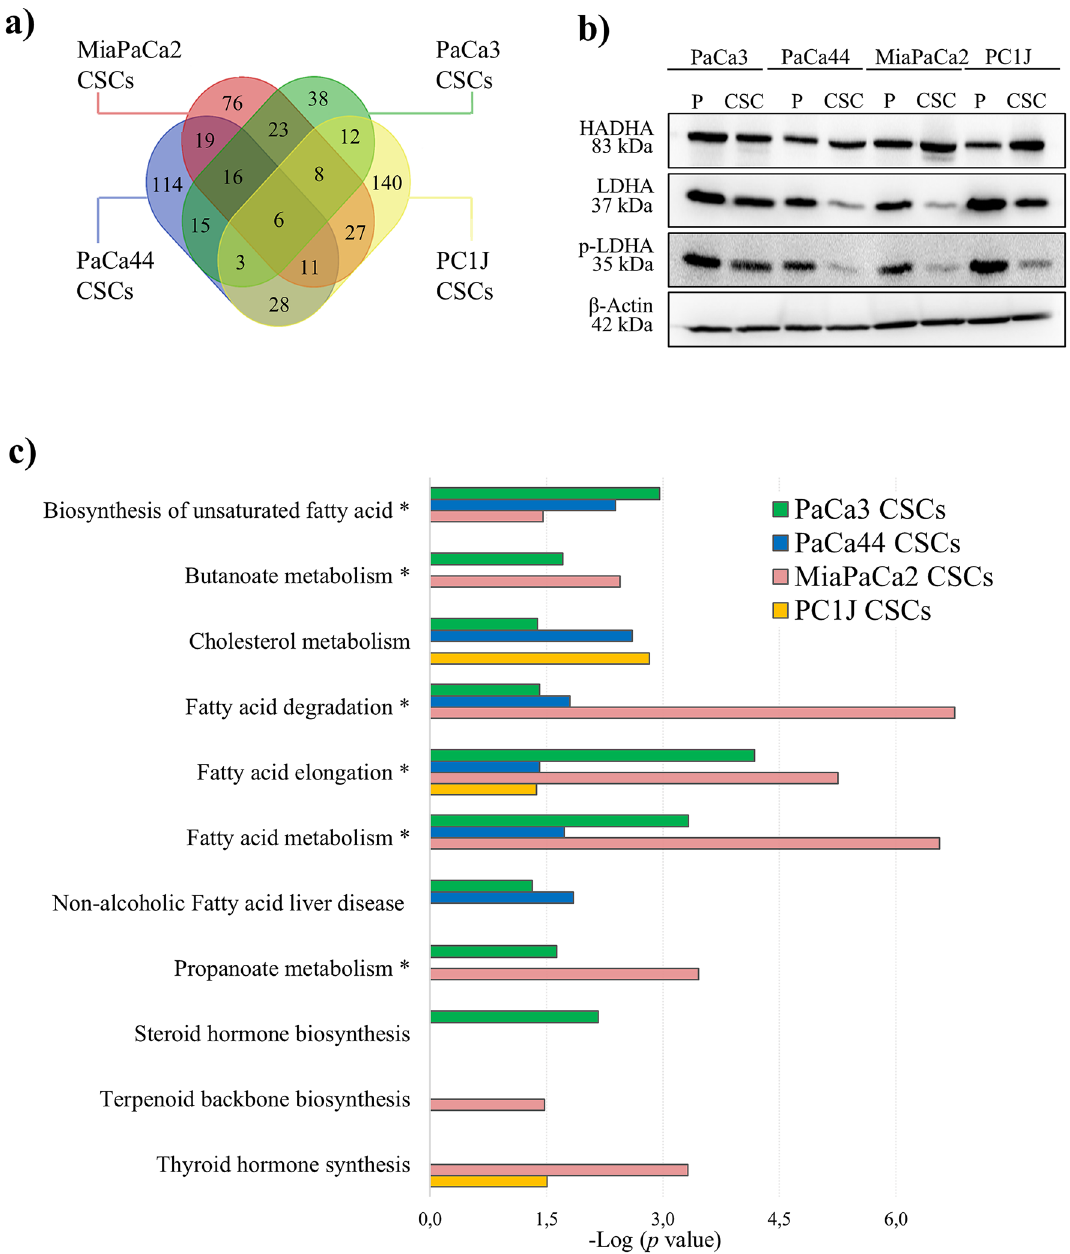
Figure 2. PCSCs display downregulated LDHA, upregulated HADHA, and some specific lipid pathways dysregulated. ( a ) Venn diagram of identified proteins dysregulated in PCSCs in comparison to P cells in the four cell lines ( p value ≤ 0.05; fold change ± 1.5). ( b ) Immunoblotting assay of HADHA, LDHA and p-LDHA proteins. β-actin was used as a loading control in Western blot analysis. The blots were cropped to focus upon the specific proteins indicated. The full-length blots are presented in Supplementary Figure S1. ( c ) The significantly enriched KEGG pathways ( p value < 0.05) of the upregulated proteins in PCSCs that are related to lipid metabolism. The asterisk indicates the pathways in which HADHA is